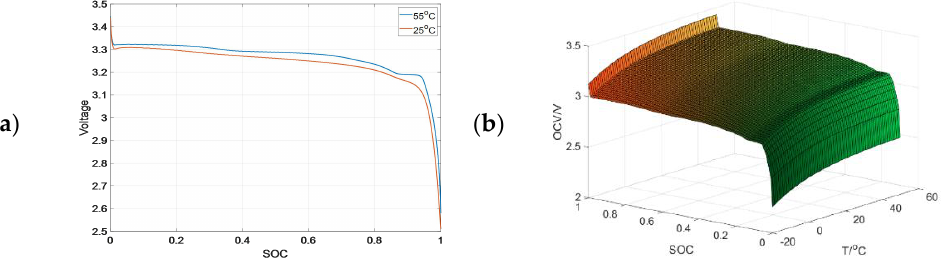
Figure 11. ( a ) Practical curve of battery OCV with battery SOC at different temperature. ( b ) Theoretical curve of battery OCV with battery SOC at different temperature.